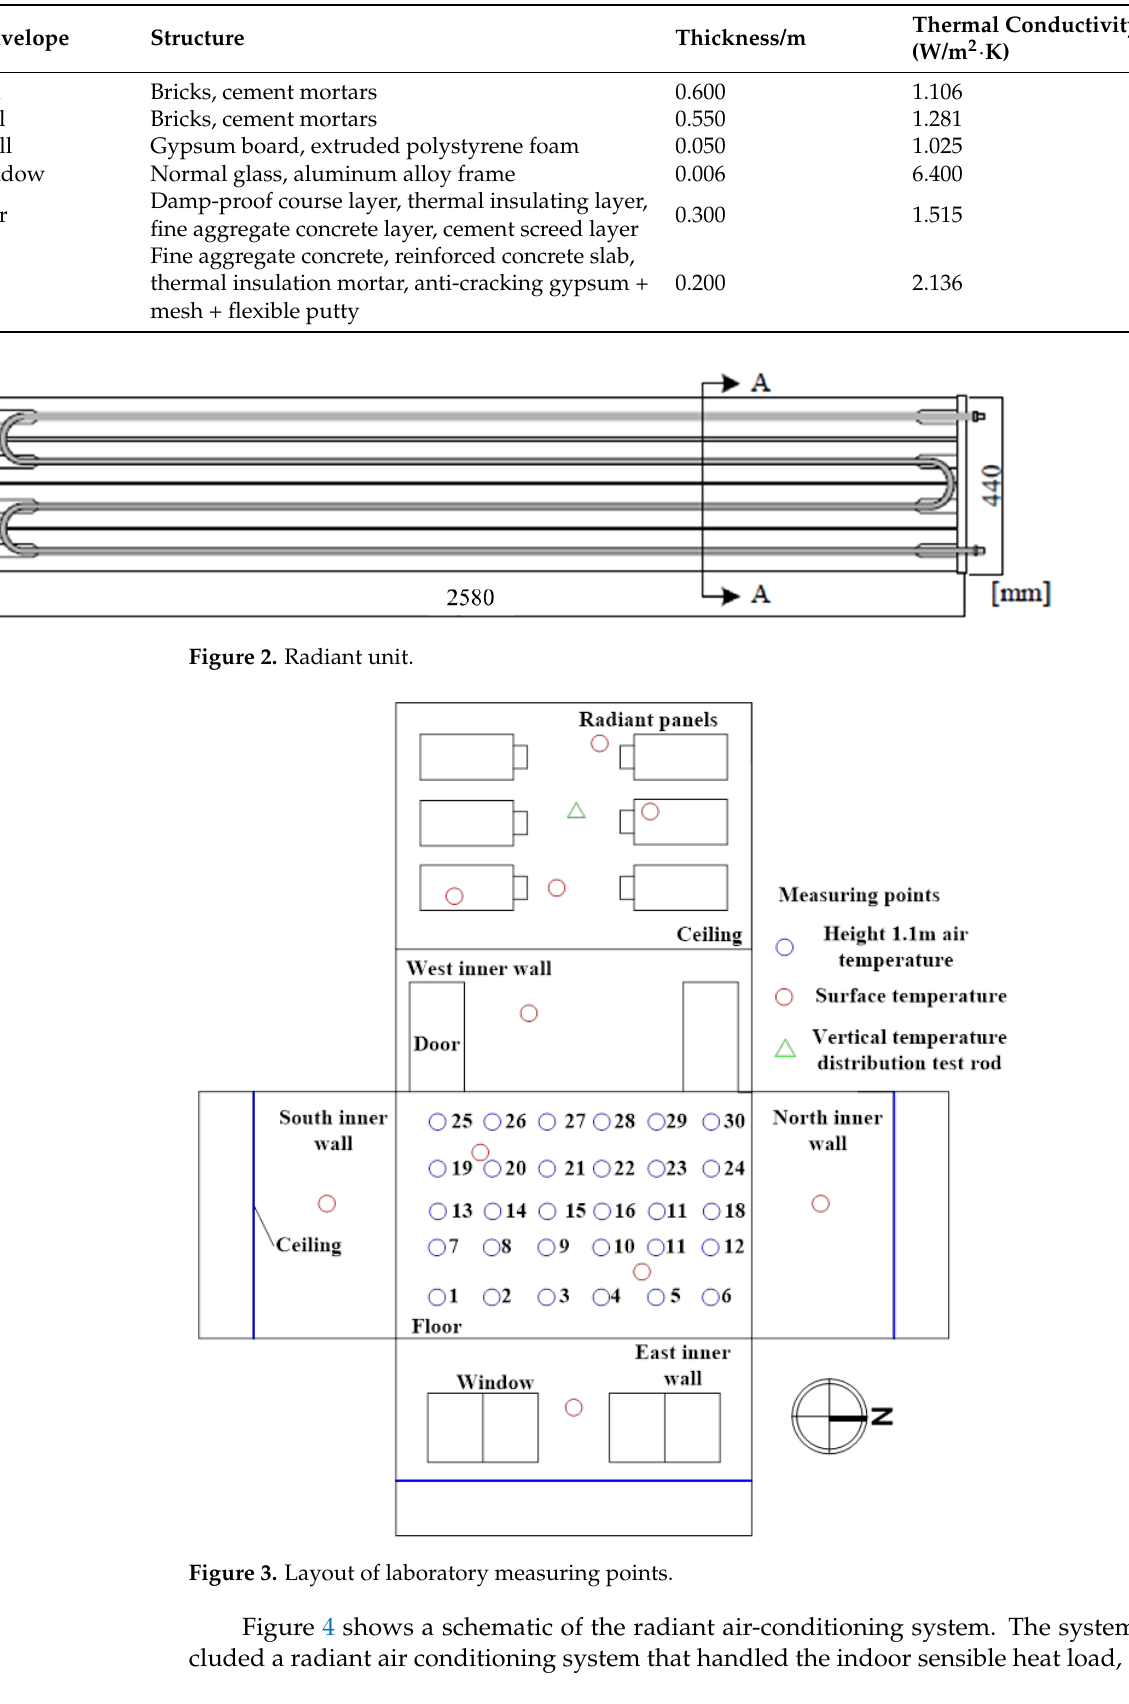
Table 1. Thermal parameters of the building envelope.